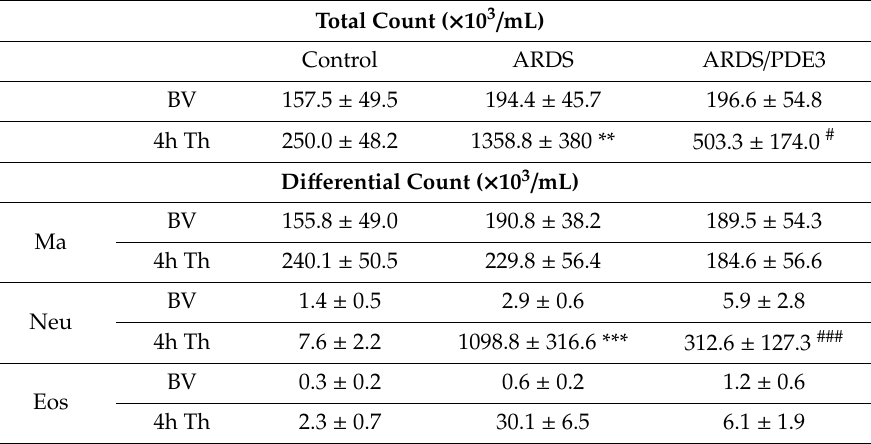
Table 1. Total count and di ff erential leukocyte count (both expressed in absolute value × 10 3 / mL) in the bronchoalveolar lavage fluid (BALF) before (basal value, BV) and in the 4 h of the therapy (Th) in healthy ventilated controls (Control), untreated group with acute respiratory distress syndrome (ARDS), and ARDS group treated with phosphodiesterase-3 (PDE3) inhibitor olprinone (ARDS / PDE3). Data are presented as means ± SEM. Ma–macrophages, Neu–neutrophils, Eos–eosinophils. Statistical comparisons: for ARDS vs. Control ** p < 0.01, *** p < 0.001; for ARDS / PDE3 vs. ARDS # p < 0.05, ### p < 0.001. Data are presented as means ±